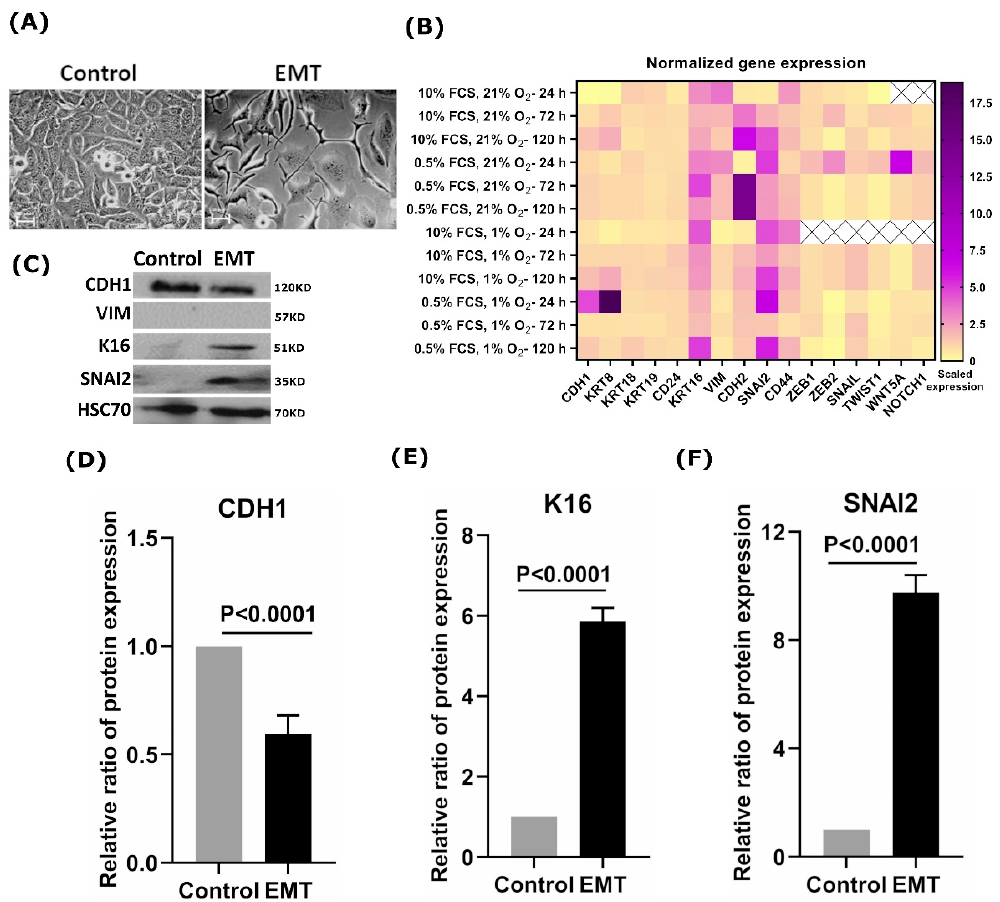
Figure 2. Analysis of the K16 expression in EMT-induced cells. ( A ) Microscopic images showed morphological changes in MCF7 cells during EMT induction; scale bar represents 100 µm. ( B ) Heat-map of EMT/MET specific genes expression in EMT-induced cells at different culture conditions and time points; relative mRNA expression values were normalized to GAPDH and subsequently displayed relative to gene expression as a fold change 2^-( ∆∆ CT). ( C ) Protein expression profile of K16, CDH1, VIM, and SNAI2 during EMT induction on MCF7 cells. HSC70 was used as a reference control. The relative ratio of protein expression of ( D ) CDH1; ( E ) K16; ( F ) SNAI2.